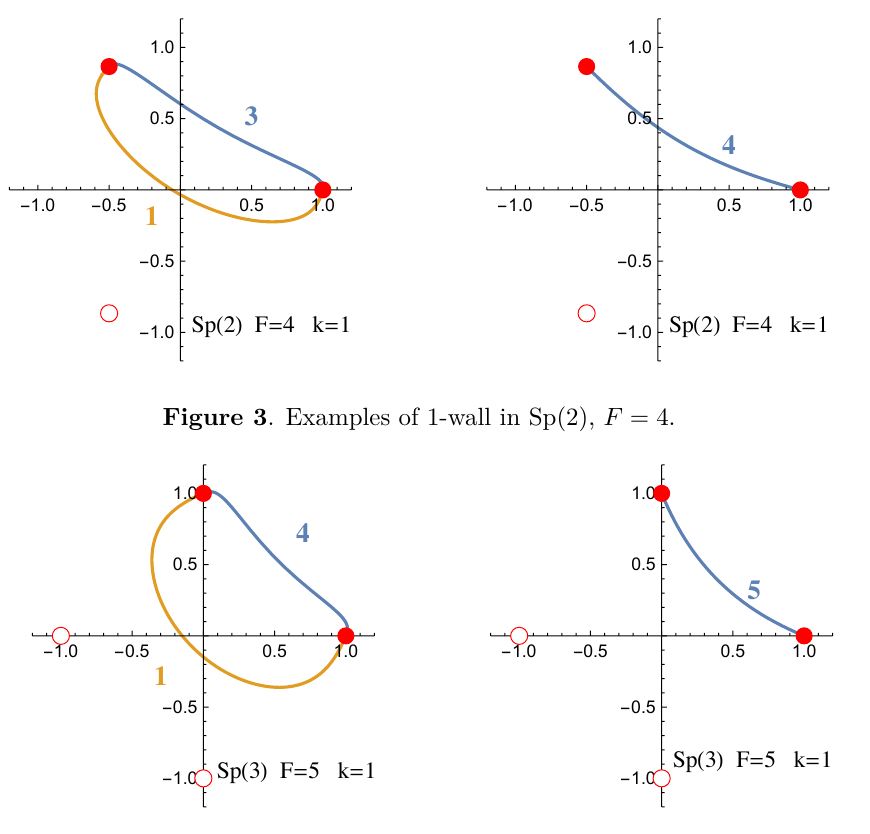
Figure 3 . Examples of 1-wall in Sp(2) , F = 4 .